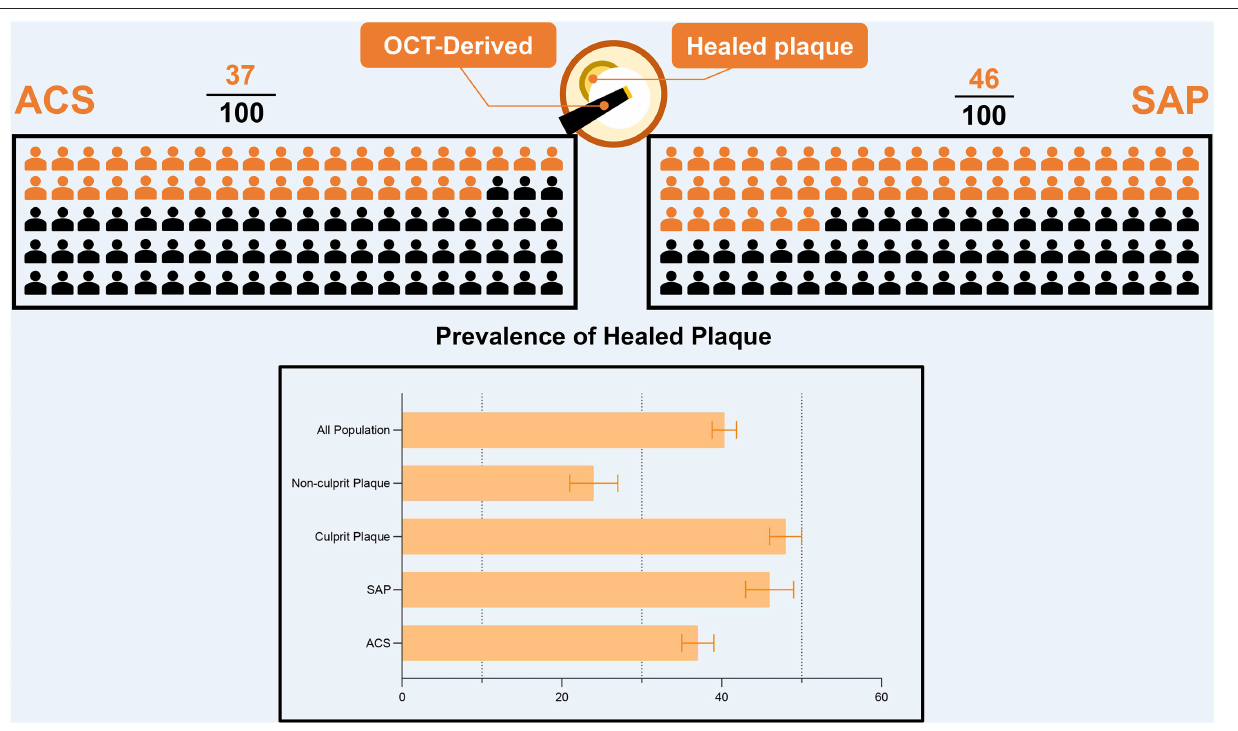
FIGURE 1 | The prevalence of healed plaque in different population. OCT, optical coherence tomography; ACS, acute coronary syndrome; SAP, stable angina pectoris.